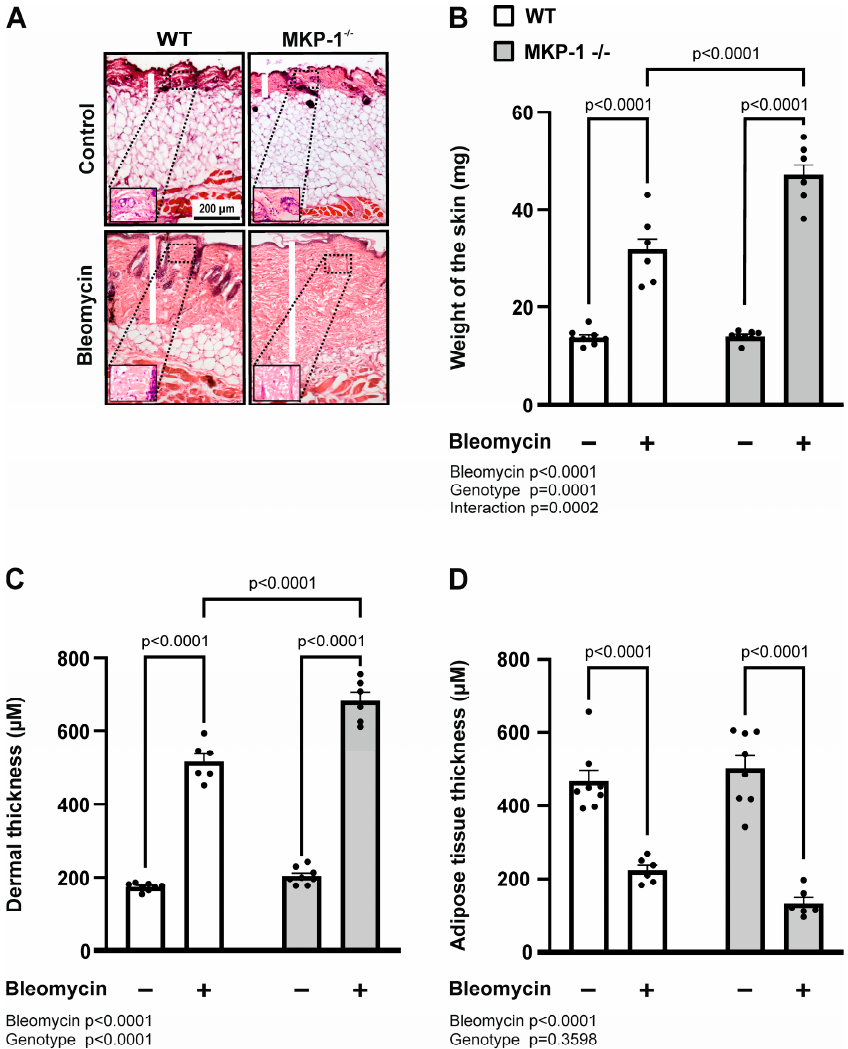
Figure 1. Dermal fibrosis is enhanced in bleomycin-treated MKP-1-deficient mice. ( A ) Representative images of H&E-stained sections of untreated control skin and skin treated with bleomycin from wild-type (WT) and MKP-1-deficient (MKP-1 − / − ) mice are shown. Original magnification 10 × , magnification in insets 20 × , scale bar 200 µ m. ( B ) Skin samples (two 6 mm skin specimens per mouse) were harvested and weighted before proceeding to the histological analyses. ( C ) Dermal thickness (rectangular blank bar as shown in A, µ m) was measured at six randomly selected locations in each section using the Image J program. ( D ) Thickness of the subcutaneous adipose tissue layer was measured by Image J program (six sites per mouse). Replicate measures were averaged per mouse. Bars represent mean + SEM; n = 8 in the control groups and n = 6 in the bleomycin-treated groups. Statistical significance of the results was calculated by two-way ANOVA followed by Tukey’s multiple comparisons test.